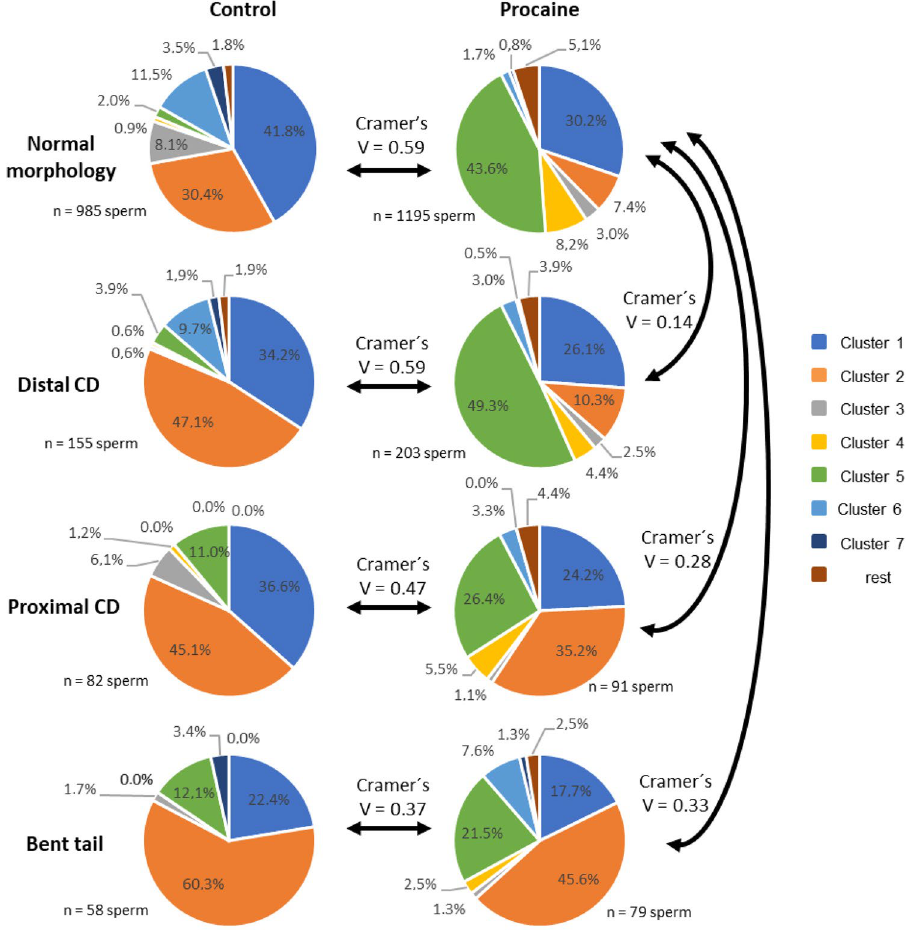
Figure 6. Effect of stimulation with procaine on the distribution of spermatozoa with a cytoplasmic droplet (CD), bent tail or normal tail morphology to clusters which represent different sperm motility patterns. Data are based on sperm tracks from semen samples (n = 10) with ≥ 15% cytoplasmic droplets or bent tails (= high MAS samples). Extended semen samples were centrifuged and incubated in non-capacitating Tyrode’s medium without procaine (control) or with 7.3 mM procaine for 10 min at 38 °C. Only clusters containing at least 5% of sperm in any of the sperm subsets analysed in Figs. 4 and 6 were considered for evaluation. Cramer’s V (range from 0 to 1) indicates the effect size of sperm morphology or procaine treatment on sperm distribution to the different clusters (movement patterns). V < 0.1 = no effect; 0.1 ≤ V < 0.3 small effect; 0.3 ≤ V < 0.5 moderate effect; V ≥ 0.5 = large